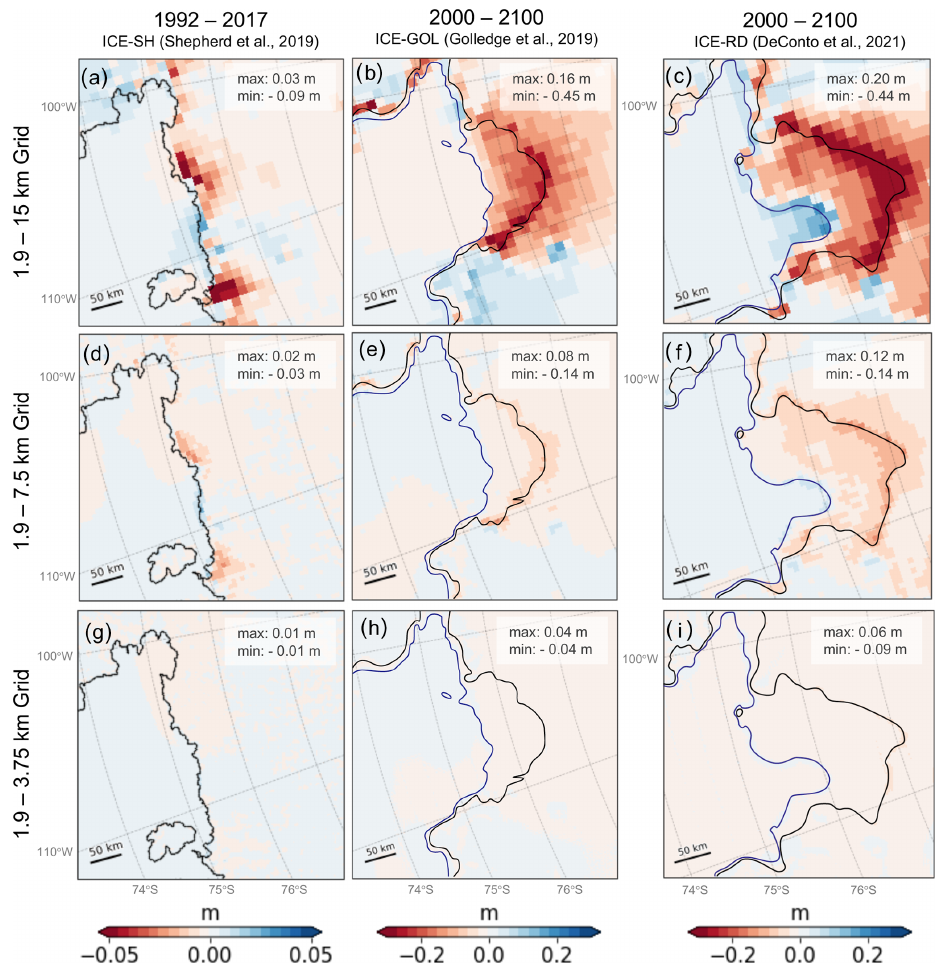
Figure 4. Influence of grid resolution on elastic sea-level predictions in ASE. Difference in predicted sea-level change in metres between (a–c) 1.9 and 15km, (d–f) 1.9 and 7.5km, and (g–i) 1.9 and 3.75km resolution GIA model simulations with a purely elastic Earth model across the times indicated at the top of the column for the ice loading scenarios (from left to right) ICE-SH, ICE-GOL and ICE-RD. For each ice retreat scenario there is a different colour bar since the magnitude of error due to grid resolution differs. In some panels, the colour bar is saturated. The black and blue lines indicate final and initial grounding lines, respectively, for each simulation, and each panel is annotated with the maximum and minimum values within the